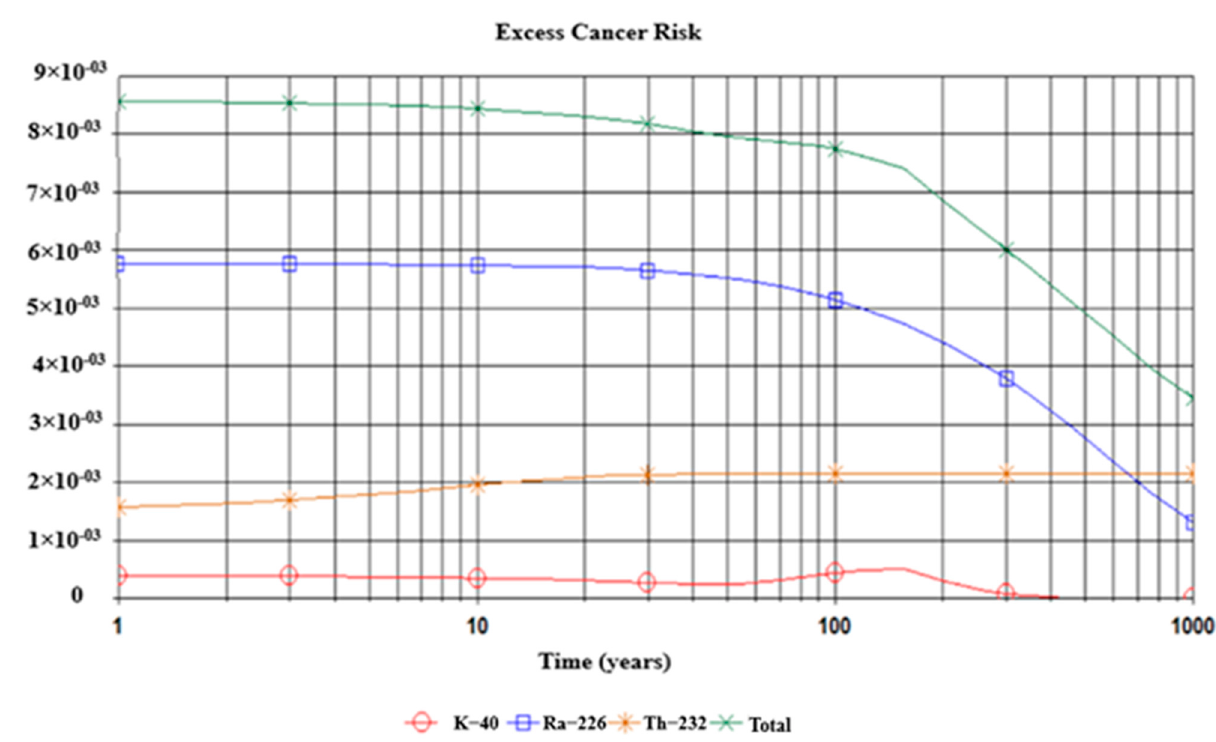
Figure 6. Long-term plotting of ECR for all exposure pathways and for each primordial radionu-